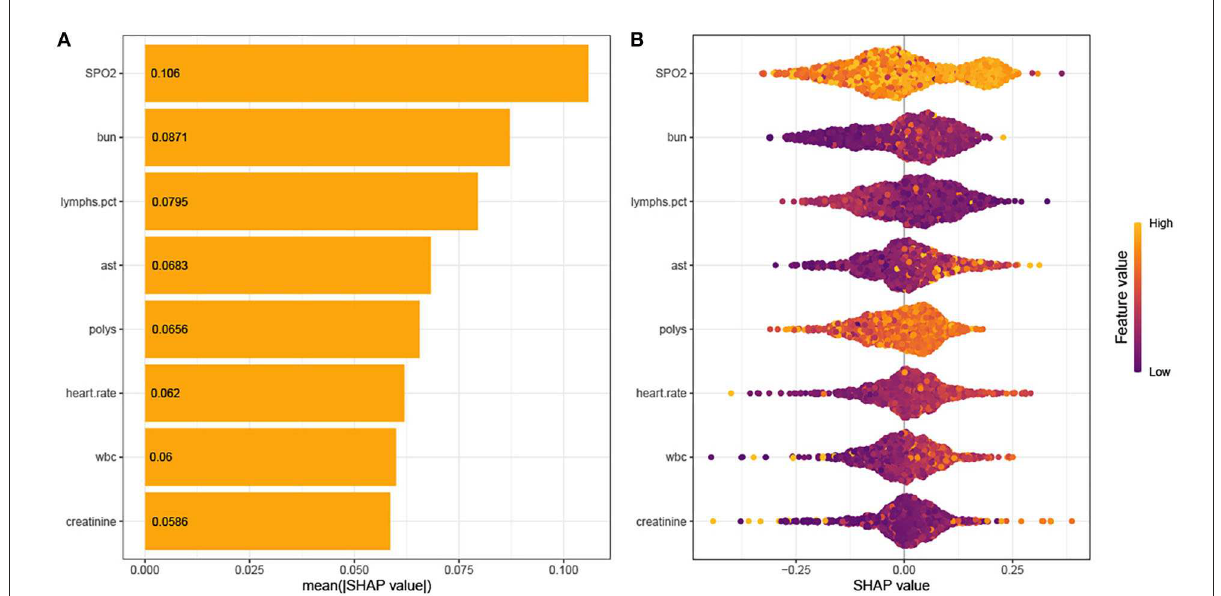
FIGURE4 (A) SHAP summary plot. (B) SHAP bee plot. Interpretation for the eight clinical features contributing to our machine learning (ML) model’s prediction for mortality. SpO 2 , oxygen saturation; BUN, blood urea nitrogen; AST, aminotransferase aspartate; Polys, percentage of polymorphonuclear granulocytes; WBC, white blood